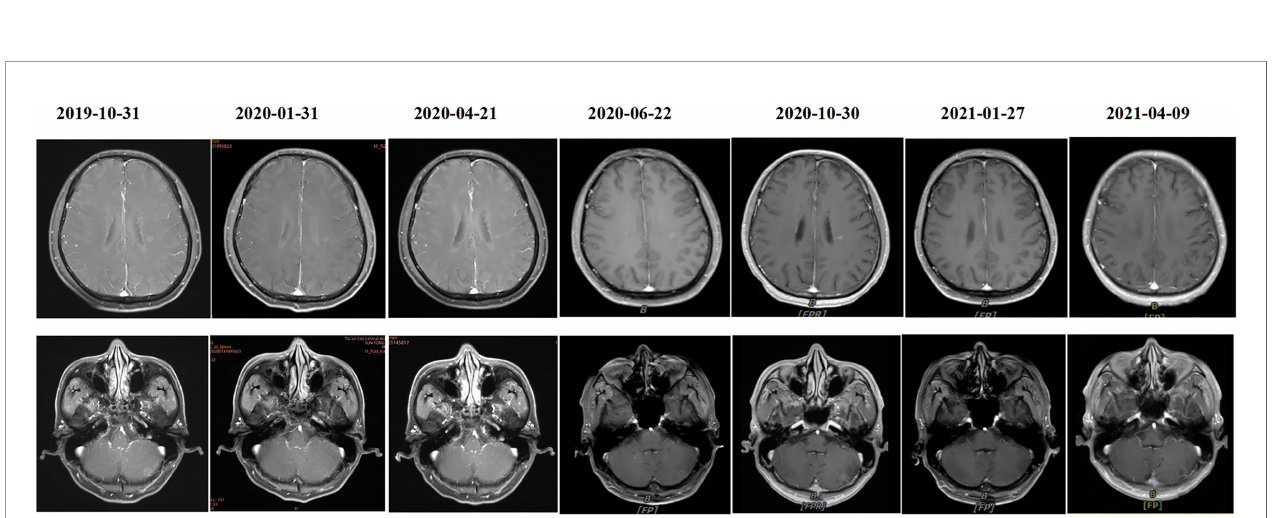
FIGURE 4 | MRI imaging changes at different time points during the treatment process.